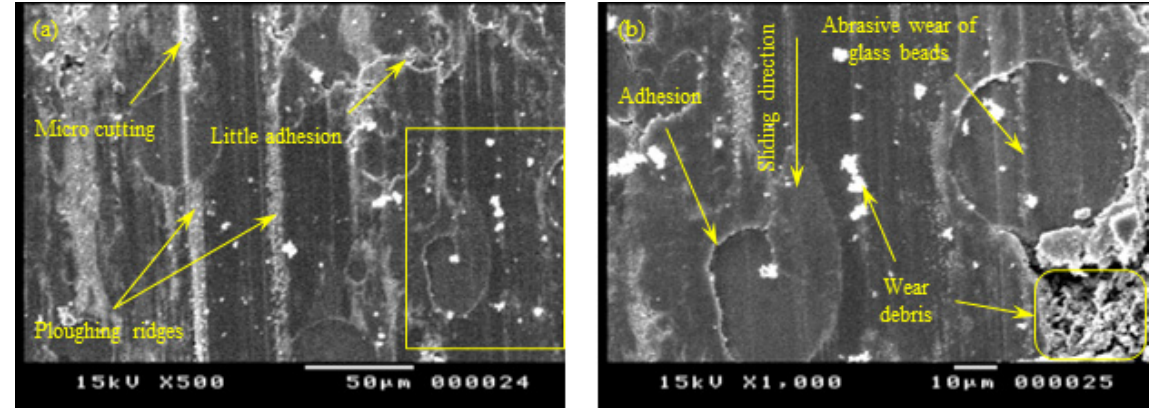
Figure 13. SEM of the tribo-surface for the Z-oriented specimen (50 N, 0.25 m/s, and 45 min) at 500× ( a ) and 1000× ( b ) magnification.